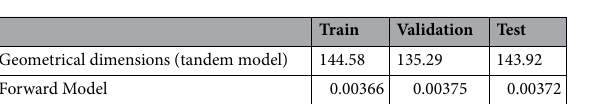
Figure 2. Network predictions of the frequency dependent absorption spectra (green curves) and the simulated spectra (black curves). The plots in the top row show examples of structure–property prediction results in comparison with a DNN-only forward model whereas the bottom row depict the forward prediction results of the same set of examples using the proposed RNN (LSTM) model.